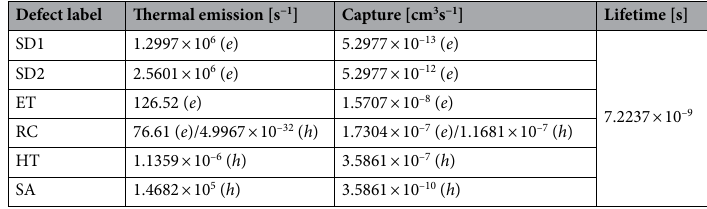
Table 2. Coefficients assumed for the kinetics simulation of charge carriers exchange rates for each defect centre in 4H-SiC material.